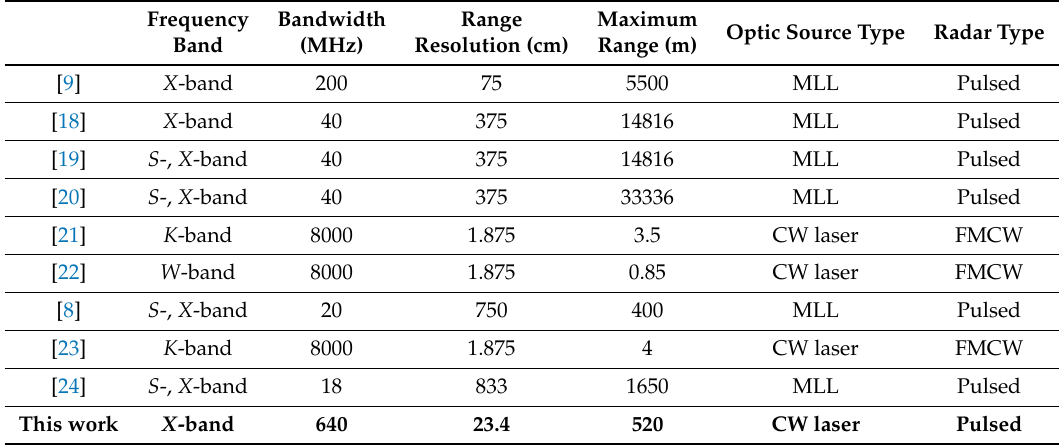
Figure 7. Target history and high-resolution range profiles of two moving targets. ( a ) Target history of when targets are at the initial position. ( b ) Target history of when targets are at the same range. ( c ) High-resolution range profiles according to the distance between two targets. Table 1. Comparison of the key performances with the previous photonic-based